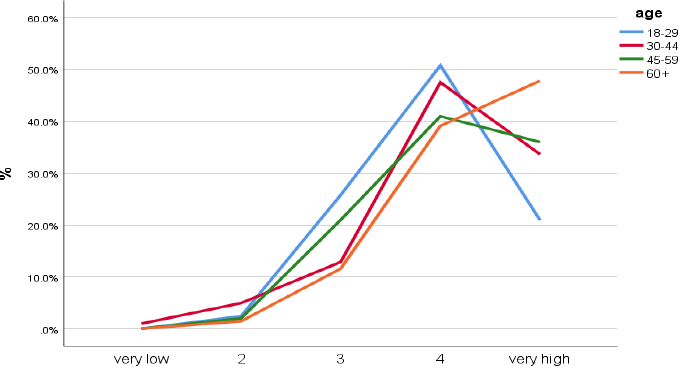
Figure 1. General assessment of the level of safety in urban parks by users (age groups) (elaborated by authors).